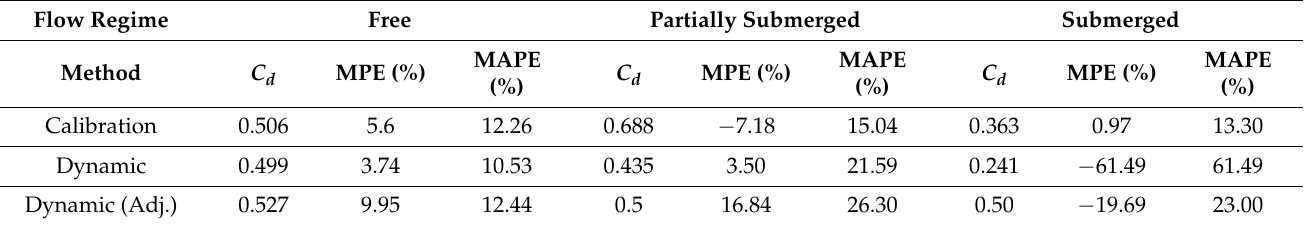
Table 4. The estimated C d for HEC-RAS and the evaluation criteria for estimated flow rates. Flow